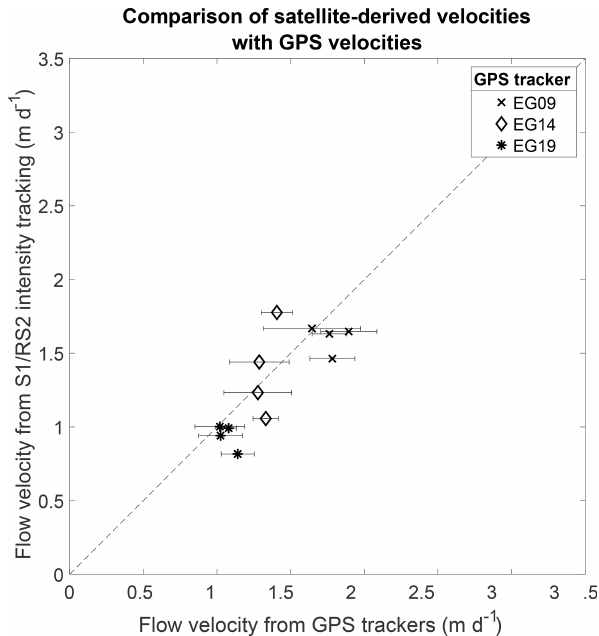
Figure 5. Comparison of satellite-derived velocities with GPS ve- locities. To account for low SNR values in areas with flow veloci- ties ∼ 1md − 1 (EG14/EG19), integration time was doubled to 24d. Vertical bars depict the standard deviation of flow speeds based on intensity tracking, and horizontal bars show the standard deviation of the GPS